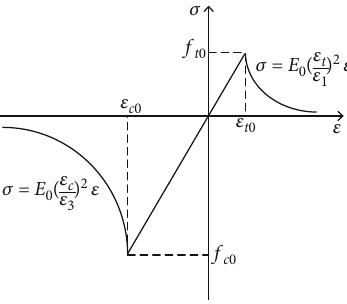
Figure 2: The damage constitutive criterion of REVs under uniaxial stress